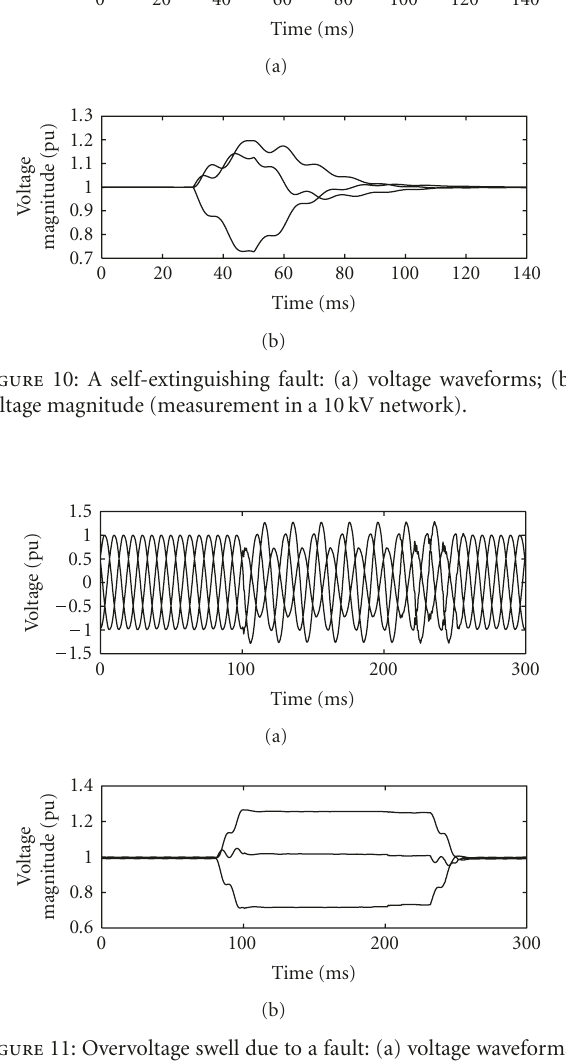
Voltage swell due to earthfault Earthfaults in nonsolidly-earthed systems result in overvolt- ages in two or three phases. An example of such an event is shown in Figure 11. In this case, the voltage rises in one phase, drops in another phase, and stays about the same in the third phase. This measurement was obtained in a low- resistance-earthed system where the fault current is a few times the nominal current. In systems with lower fault cur- rents, typically both nonfaulted phases show an increase in voltage